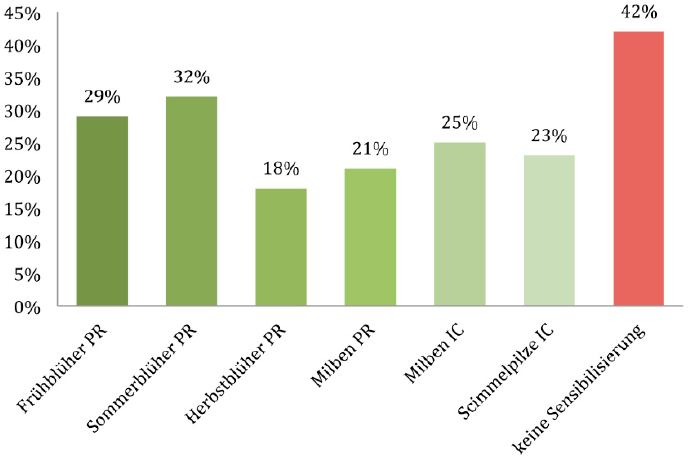
Figure 1. Prevalence of sensitization to the different allergen groups; PR = Prick test, IC = Intracuta- neous test.